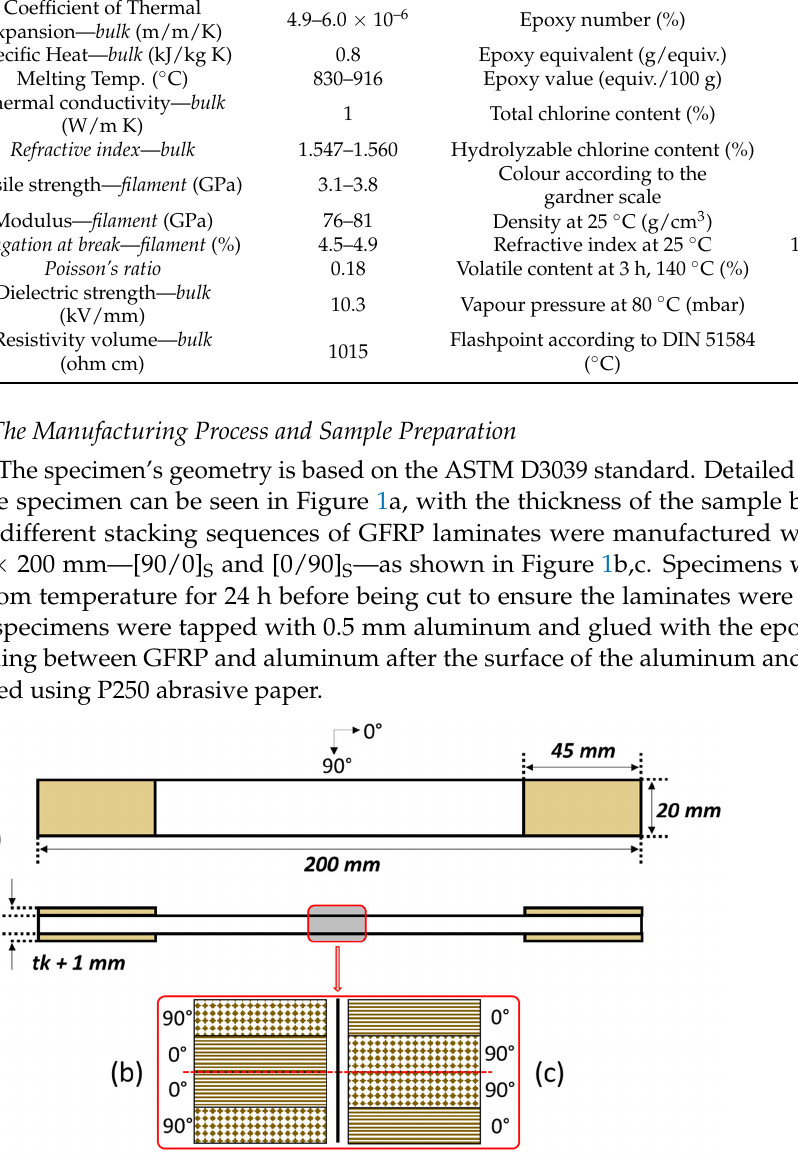
Figure 1. Specimen configuration. ( a ) ASTM D3039 dimension. ( b ) Layer configuration of [90/0] S . ( c ) Layer configuration of [0/90] S.